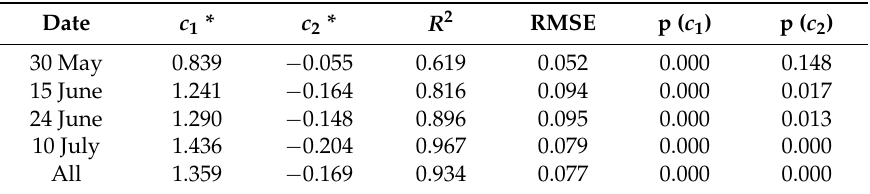
Figure 10. Scatter plot of Normalized Difference Vegetation Index (NDVI) derived from ASTER and the in-situ FAPAR measurements from different dates. Table 4. Statistics of the fit using various subset of in-situ data.